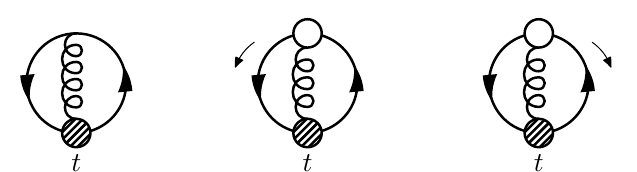
Figure 3 . Feynman diagrams for the matching calculation of the flowed qCMDM operator onto the